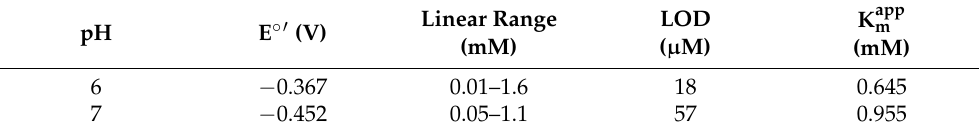
Table 1. Comparison of Glu-sensing performance of NF-GLA/MWCNTs-BSA-HFs-GOD/GCE in 50 mM phosphate-buffered solution at different pH levels.